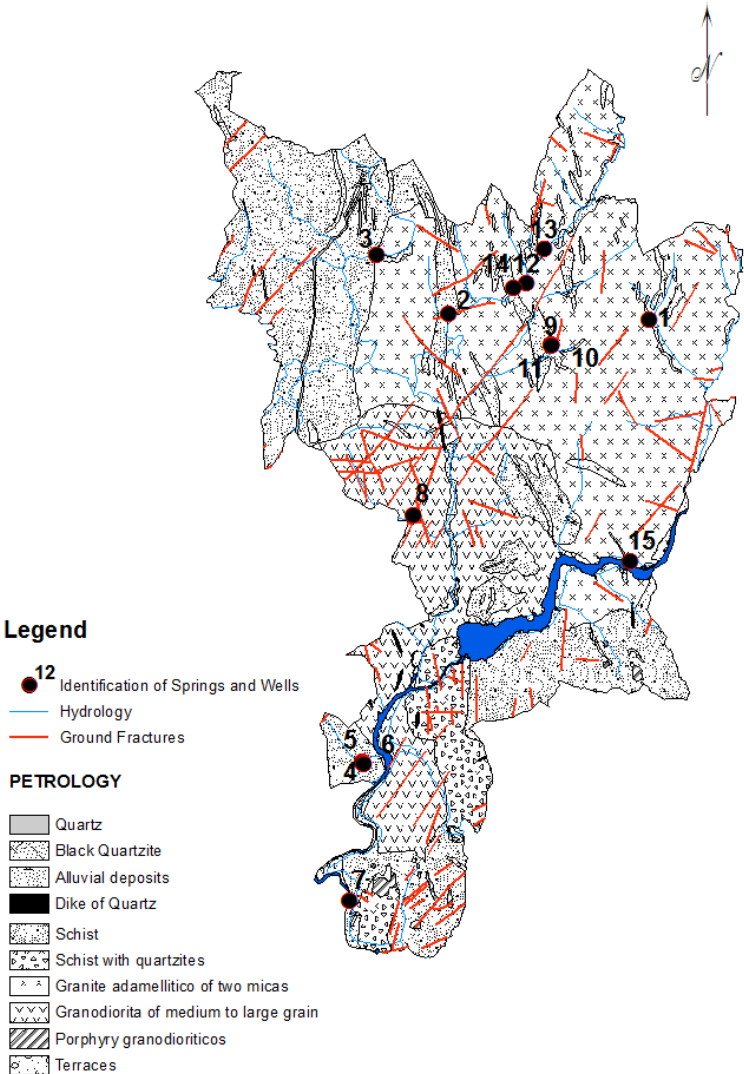
Fig. 1. Geological map with the sampling sites.